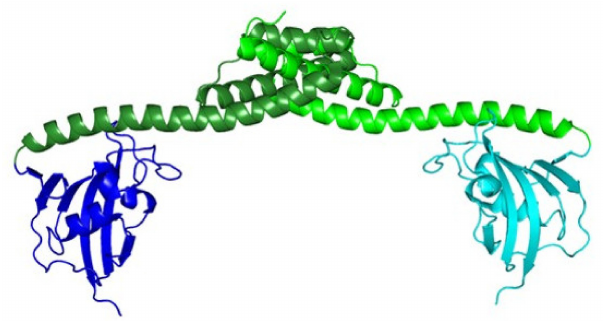
Figure 4. 3D structure of FkpA as a dimer. The structure of each protomer is represented in cartoon. The chaperone domains of both protomers are represented in light green and dark green, respectively. Their PPIase domains are represented in turquoise and dark blue, respectively. The dimerization interface is localized at the level of the chaperone domains (PDB entry: 1Q6U). The figure